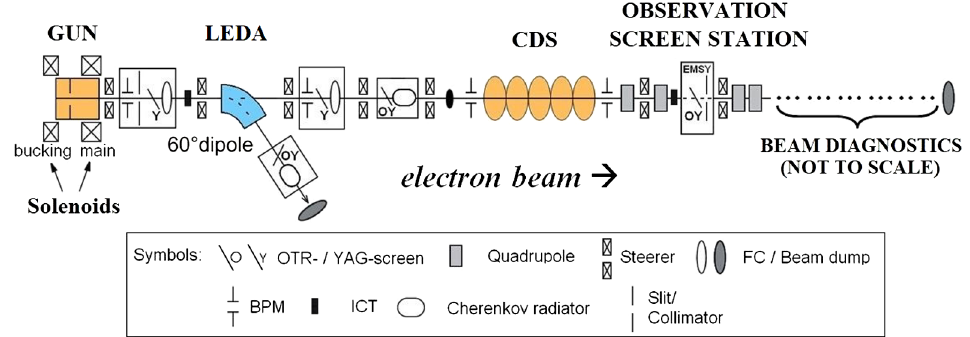
FIG. 10. Sketch of the partial PITZ beam line. CDS: cut-disk-structure. LEDA: low energy dispersive